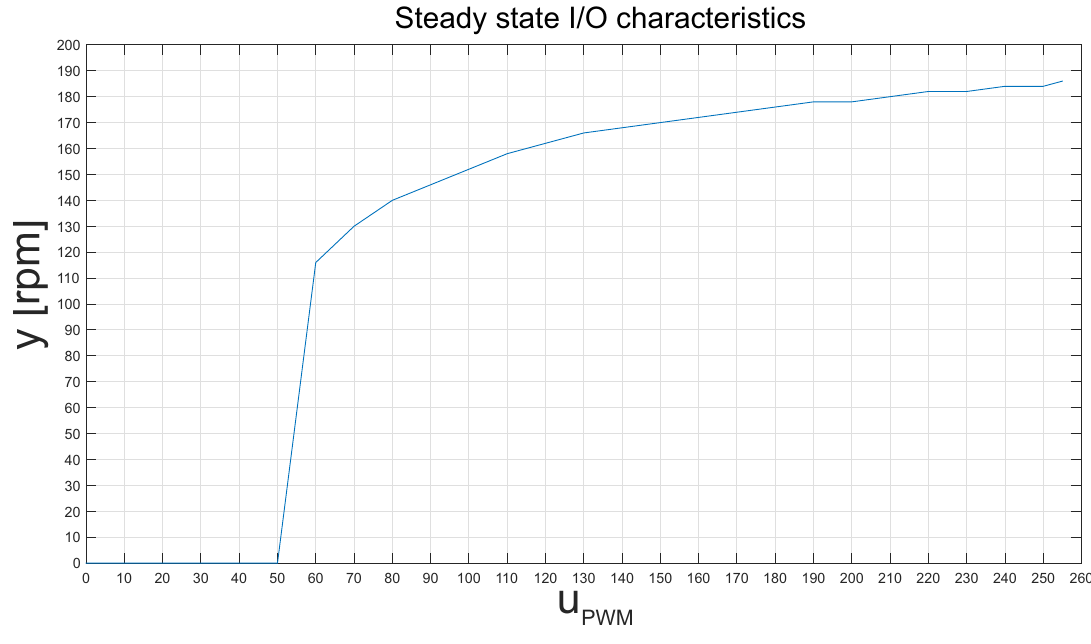
Figure 12. Steady state I/O characteristics of DC